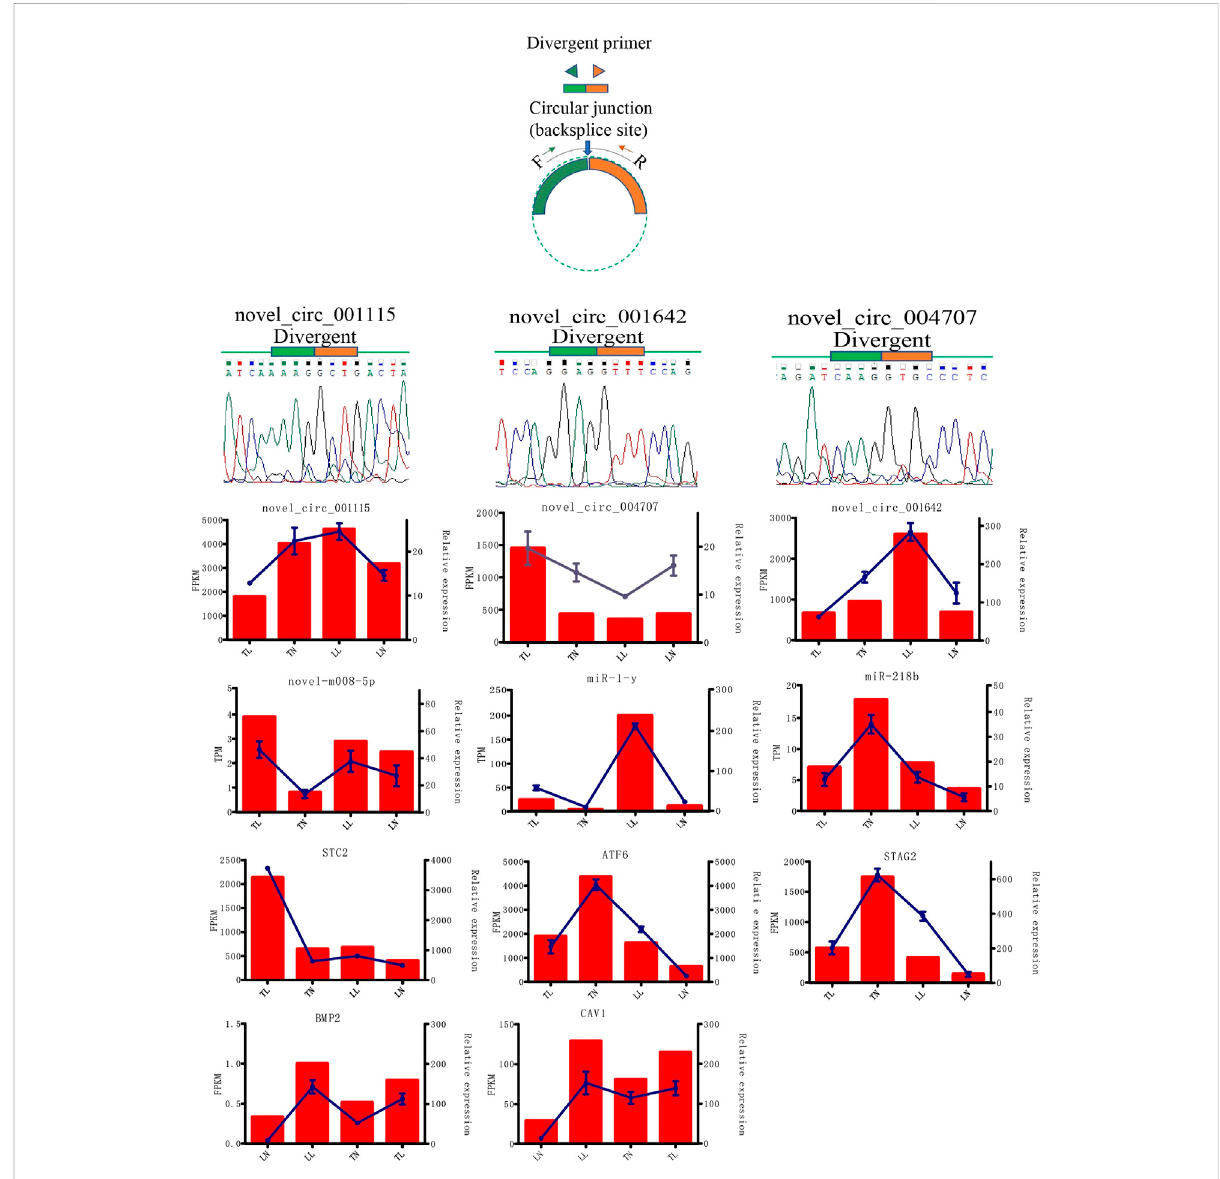
FIGURE 3 Expression patterns of randomly selected 3 DEcircRNAs, 3 DEmiRNAs and 3